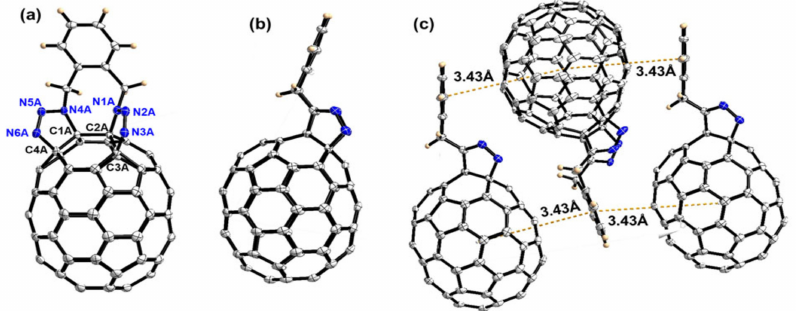
Figure 2. Ortep drawing of 2 showing thermal ellipsoids at the 40% probability level: ( a ) front view and ( b ) side view. Solvent molecules are omitted for clarity; ( c ) the crystal packing of 2 shows the π – π interaction between molecules.